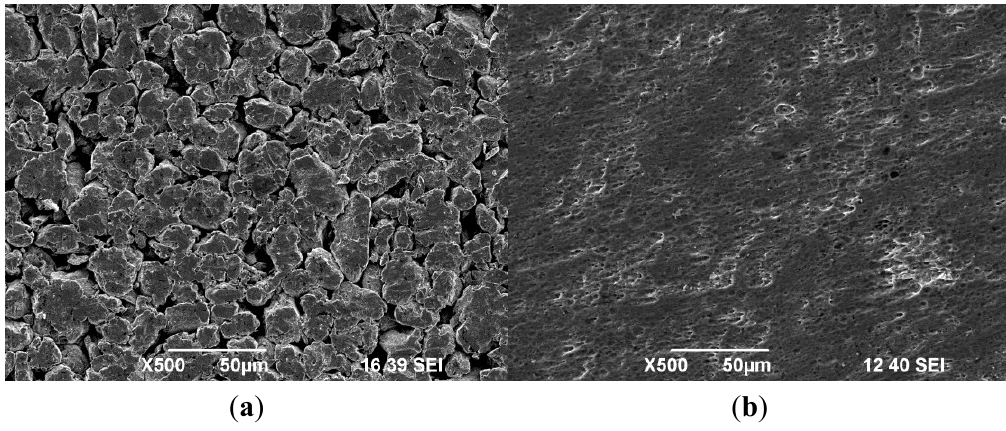
Figure 1. ( a ) The morphology of Ti Grade 2 powder produced by cryogenic milling and pre-compacted under a pressure of 1.95 GPa; ( b ) the sample’s surface in the peripheral part of the sample after five turns of high pressure torsion (HPT) at 573